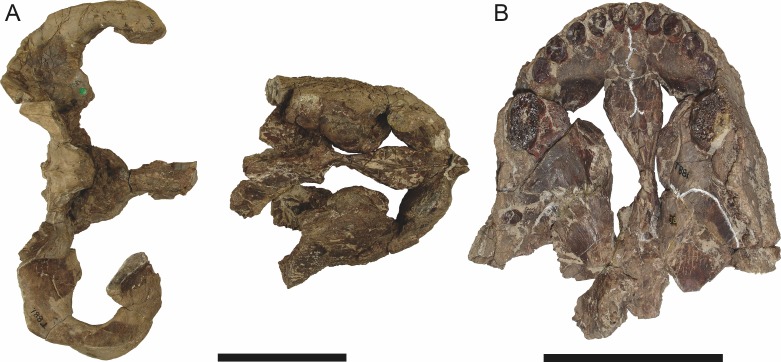
Referred skull (UMZC T881) of Ruhuhucerberus haughtoni (Huene, 1950) in (A) dorsal and (B) ventral view.Anterior is right in (A) up in (B). Scale bars equal 10 cm.